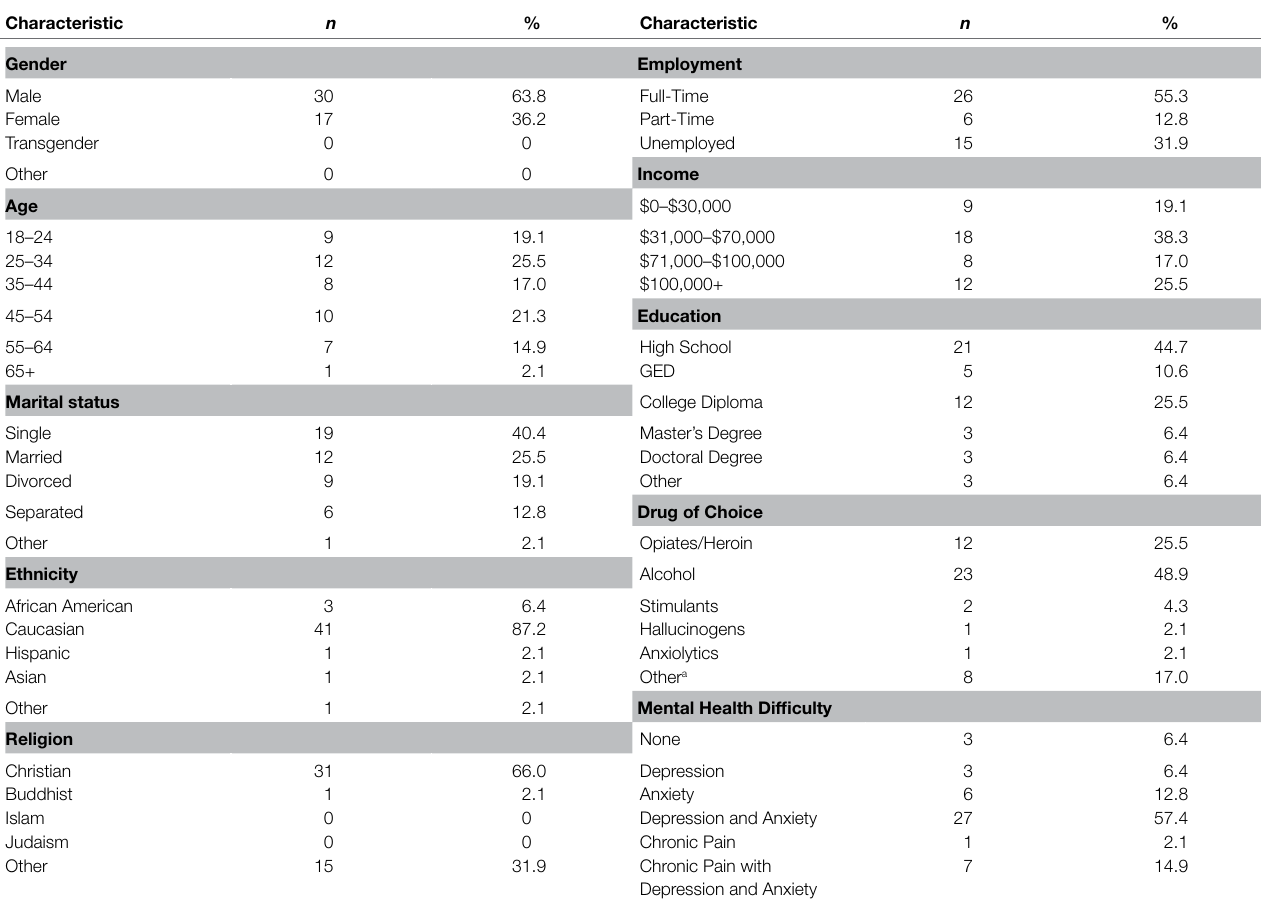
TABLE 1 | Sociodemographic characteristics of